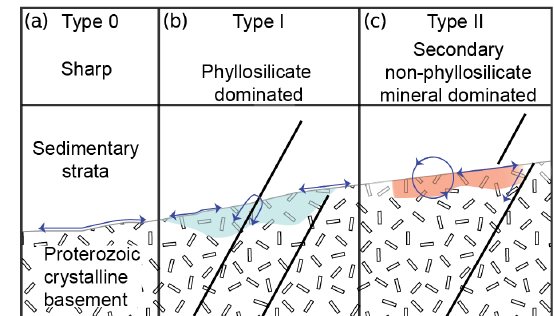
Figure 13. Proposed geologic schematics of the nonconformity contact region. (a) Type 0 – sharp contact expected to prevent di- rect fluid pressure communication across the contact while promot- ing migration parallel to the contact distributing fluids laterally. (b) Type I – phyllosilicate-dominated zone above the crystalline basement is expected to inhibit fracture propagation across the non- conformity, prevent fluid migration due to permeability contrast, and promote lateral migration; downward fluid migration can occur at a permeable fault zone. (c) Type II – secondary-mineralization- dominated zone with lateral migration due to permeability contrast; mineralization due to fluid–rock interactions suggests that deep fluid circulation occurs even without enhanced permeability from fractures. All nonconformity types may be cut by structural discon- tinuities. Blue arrows indicate potential flow paths of injected